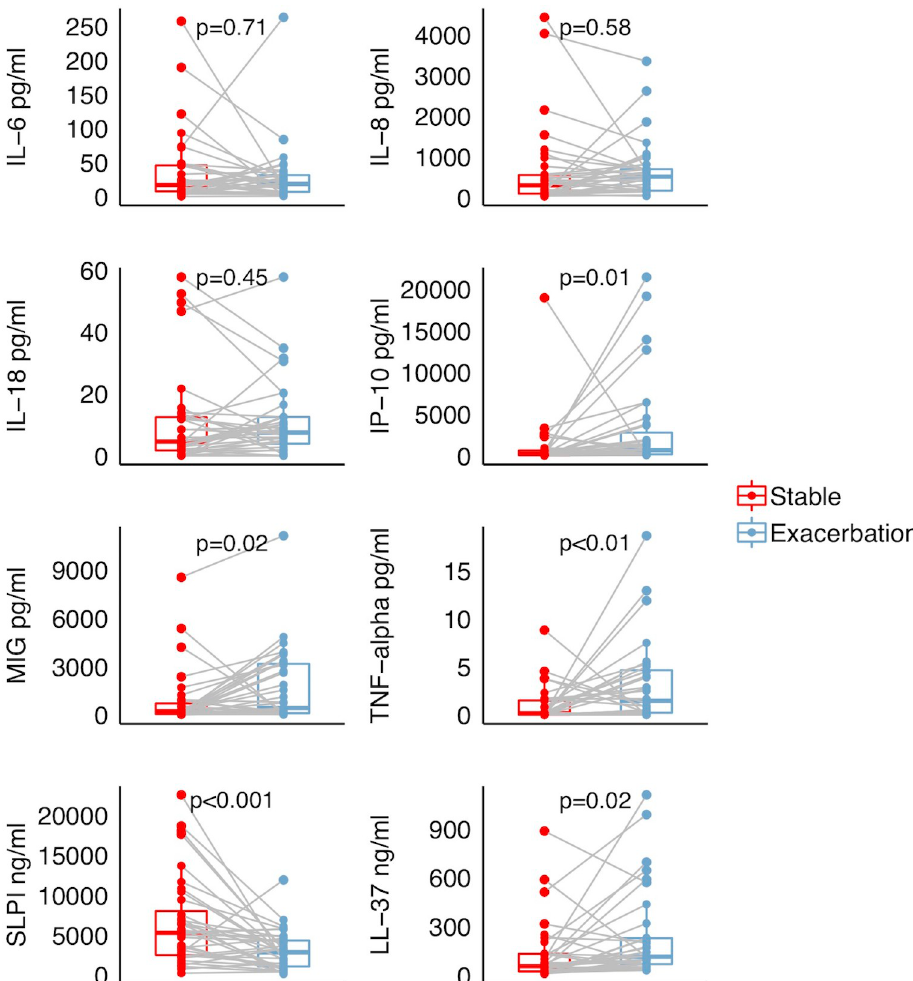
Fig 2. Inflammatory markers and antimicrobial peptides in induced sputum collected from a COPD cohort at stable state and during exacerbation. Interleukin-6 (IL-6), Interleukin-8 (IL-8), Interleukin-18 (IL-18), Interferon Gamma-Induced Protein 10 (IP-10), Monokine induced by gamma interferon (MIG): n = 35. Secretory Leukocyte Protease Inhibitor (SLPI): n = 36. LL-37/hCAP-18: n = 34. Boxes show the interquartile range (IQR = 75 th percentile- 25 th percentile), with medians marked by the horizontal line within each box. Samples collected from the same patient at different disease states are connected by lines. Wilcoxon signed rank test was applied based on the paired, non- parametric